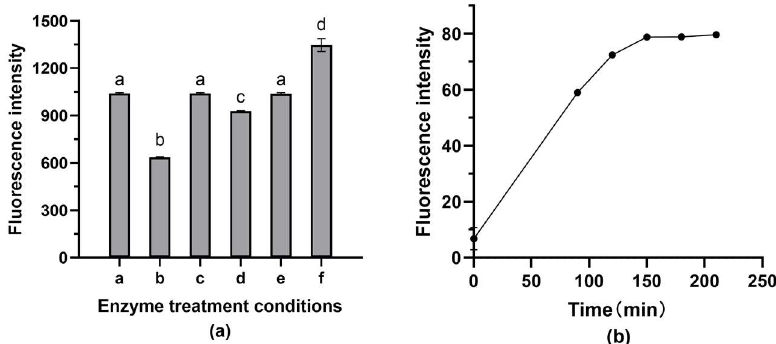
Figure 6. Effects of enzyme treatment conditions on the fluorescent detection of S. aureus . ( a ) a: 1 mg/mL lysozyme; b: 1 mg/mL lysozyme and 10 µ L/mg lysostaphin; c: 2 mg/mL lysozyme and 10 µ L/mg lysostaphin; d: 5 mg/mL lysozyme and 10 µ L/mg lysostaphin; e: 10 µ L/mg lysostaphin; and f: treatment without the addition of enzymes. ( b ) Hybridization time. Bars show the means and the error bars show standard deviations. The a, b, c, d in the figure indicate significant differences between multiple groups.